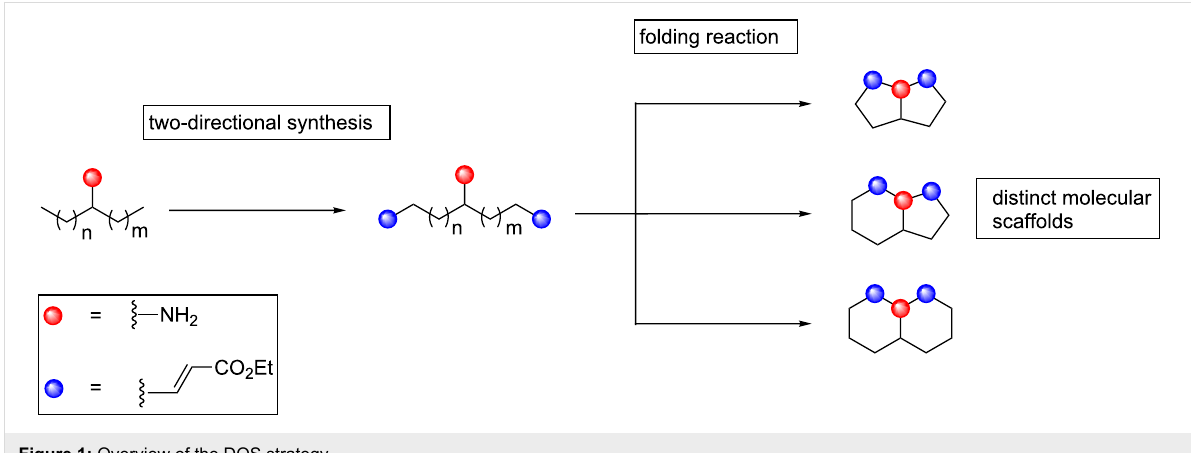
Figure 1: Overview of the DOS